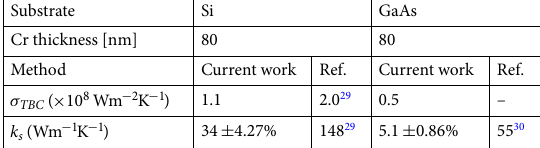
Substrate Si GaAs Cr thickness [nm] 80 80 Method Current work Ref. Current work